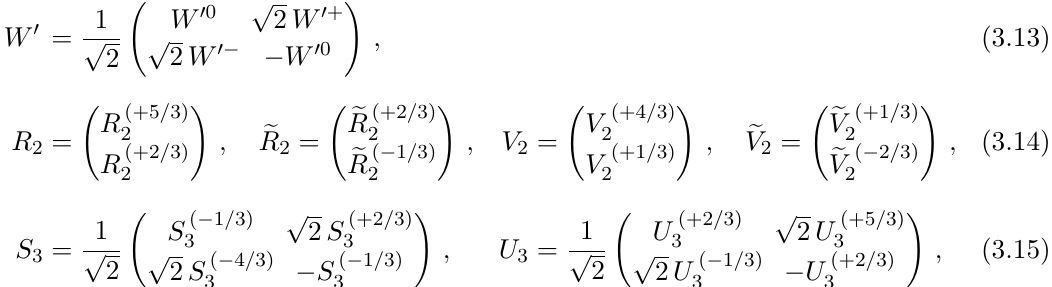
, d ≡ d , e ≡ ‘ R R R ) T and l ≡ ( ν ) T . We adopt L , d L L , ‘ L